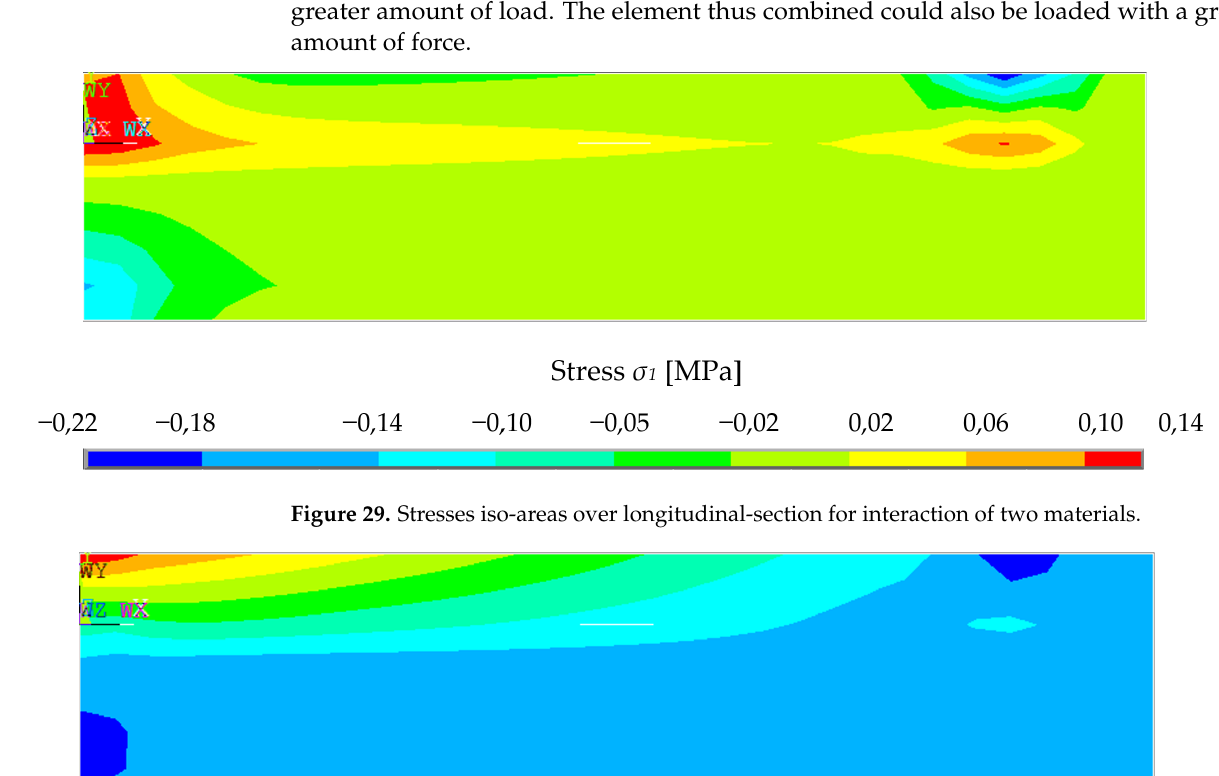
Figure 28. Detail of delamination- specimen 24030420.